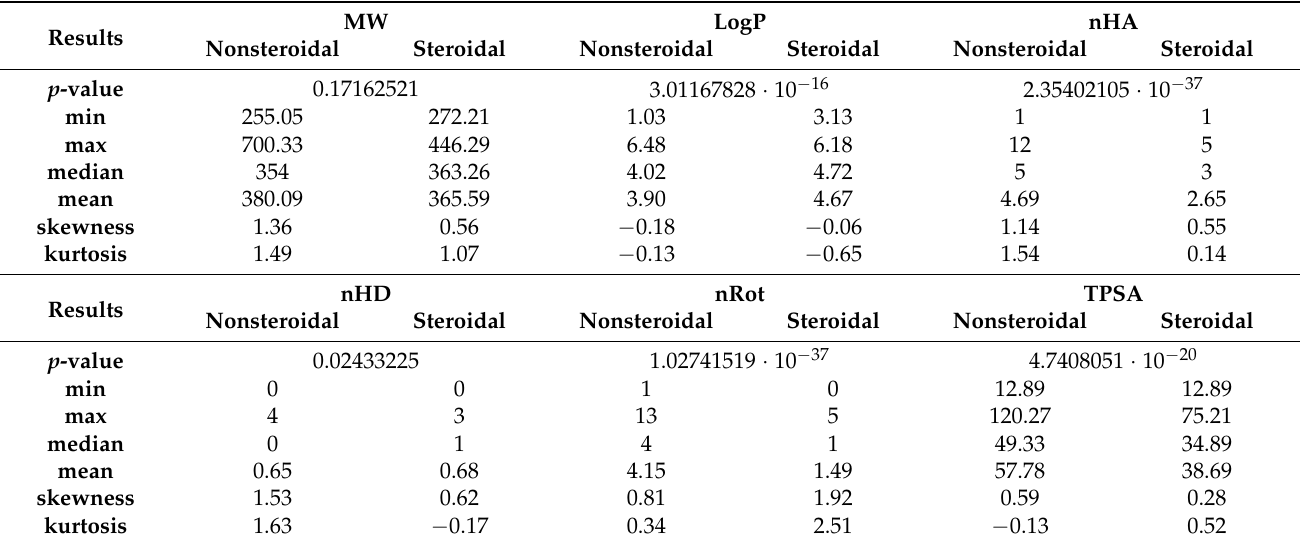
Table 1. Exploratory data analysis and comparison performed for nonsteroidal and steroidal in- hibitors. Six drug-likeness descriptors were employed. They included molecular weight (MW), the octanol-water partition coefficient (LogP), the number of hydrogen bond acceptors (nHA), the number of hydrogen bond donors (nHD), the number of rotatable bonds (nRot), and the topological polar surface area (TPSA).